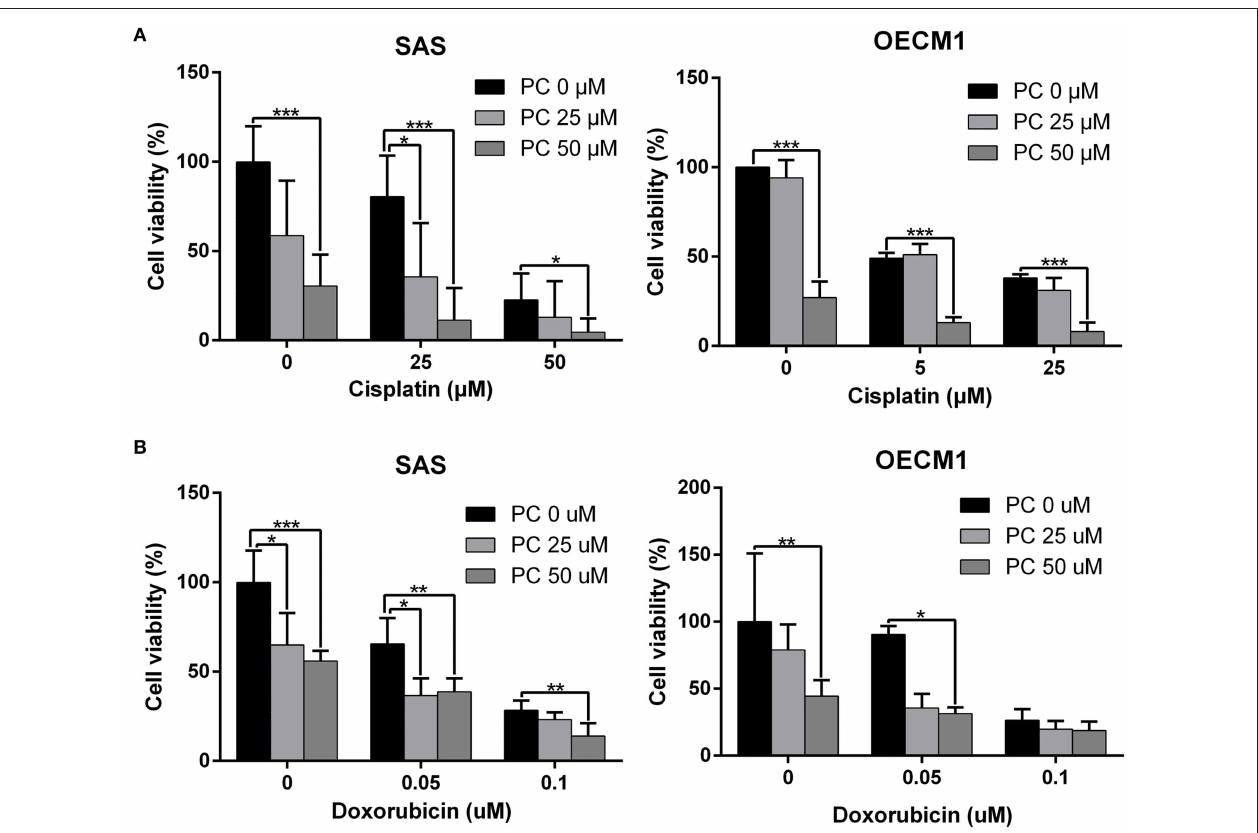
FIGURE 4 | Psorachromene combined with cisplatin and doxorubicin has additive effect. The effects of psorachromene combined with cisplatin and doxorubicin on proliferation of SAS (A) and OECM1 (B) cells. * p < 0.05, ** p < 0.01, *** p < 0.001. All experiments were performed in